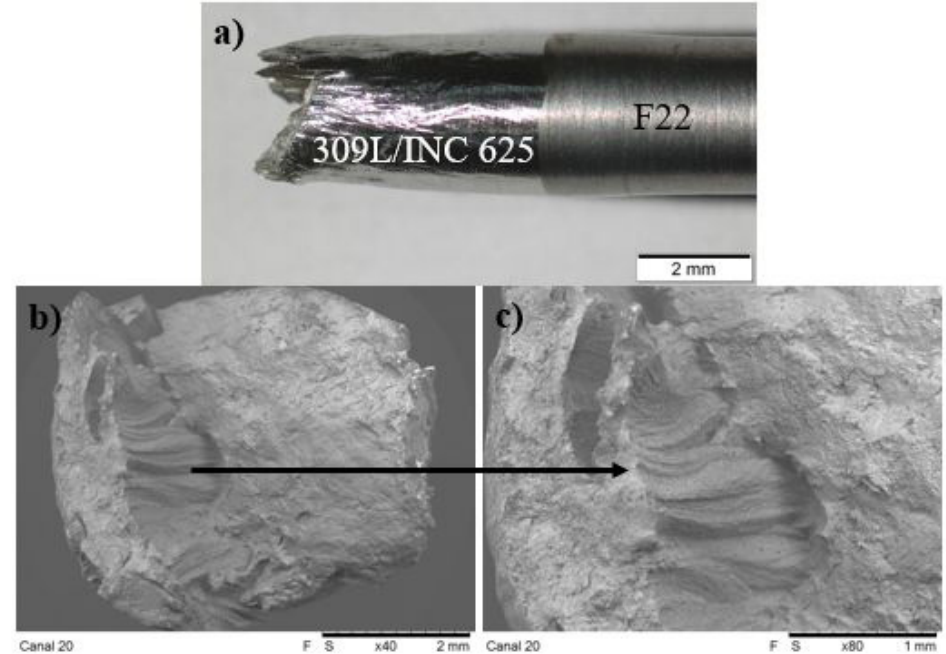
Figure 11. Tensile tests aspects, J309 welded joint, a) absence of necking on the 309L-Si weld fracture section, b) surface aspect on the 309L-Si weld brittle cross section, c) crack on the brittle fracture surface.